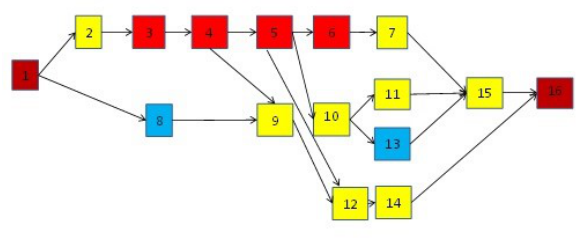
Figure 2: Network diagram of the construction Project. Table 1: The project schedule